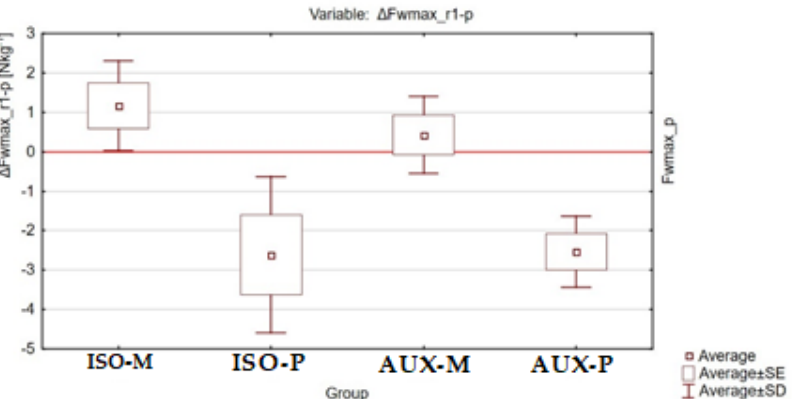
Figure 4. Graphical representation of the results of ANOVA Kruskal –Willis analysis for the ΔFw- max_w-p variable between all tested groups of participants.